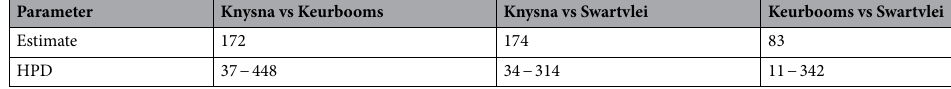
Table 1. Population splitting times (in years) between populations of Hippocampus capensis estimated based on the microsatellite loci. The peak (mode) as well as the 95% highest posterior density (HPD) intervals are shown.